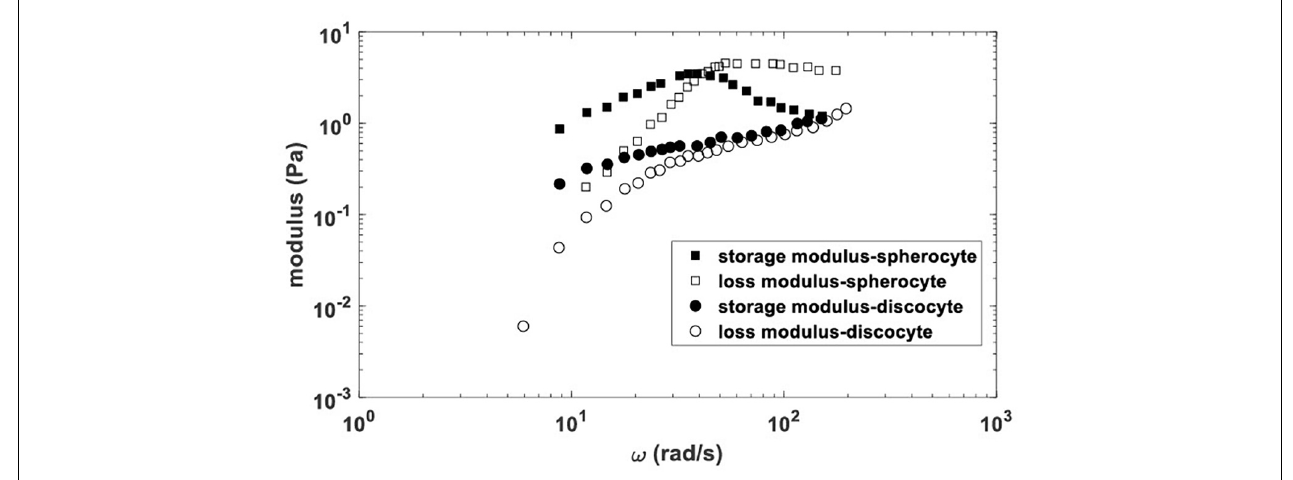
FIGURE 2 | Storage and loss moduli vs. angular velocity for spherocytes and discocytes extracted from microrheological data published by Park (2007) and Amin et al. (2007).